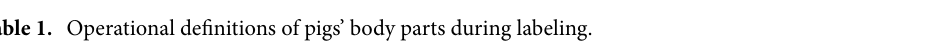
Table 1. Operational definitions of pigs’ body parts during labeling.